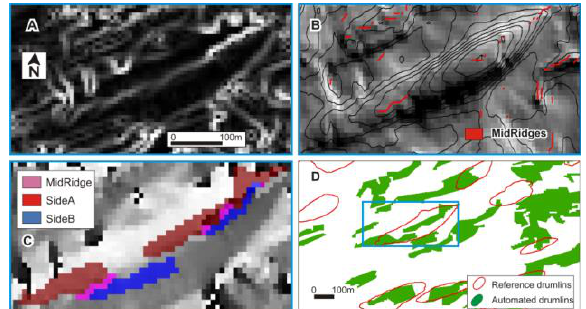
Figure 6. Testing the terrestrial set of rules to automatically extract submarine drumlin perimeters from a DEM, (A) the gradient in values of aspect, amplified via the Sobel edge detection filter (B) the terrestrial set of rules fails to extract the top middle ridges, (C) the unsatisfactory extraction of the three parts of the submarine drumlin, and (D) automatically extracted drumlin polygons do not compare well with the manually digitized drumlin polygons.